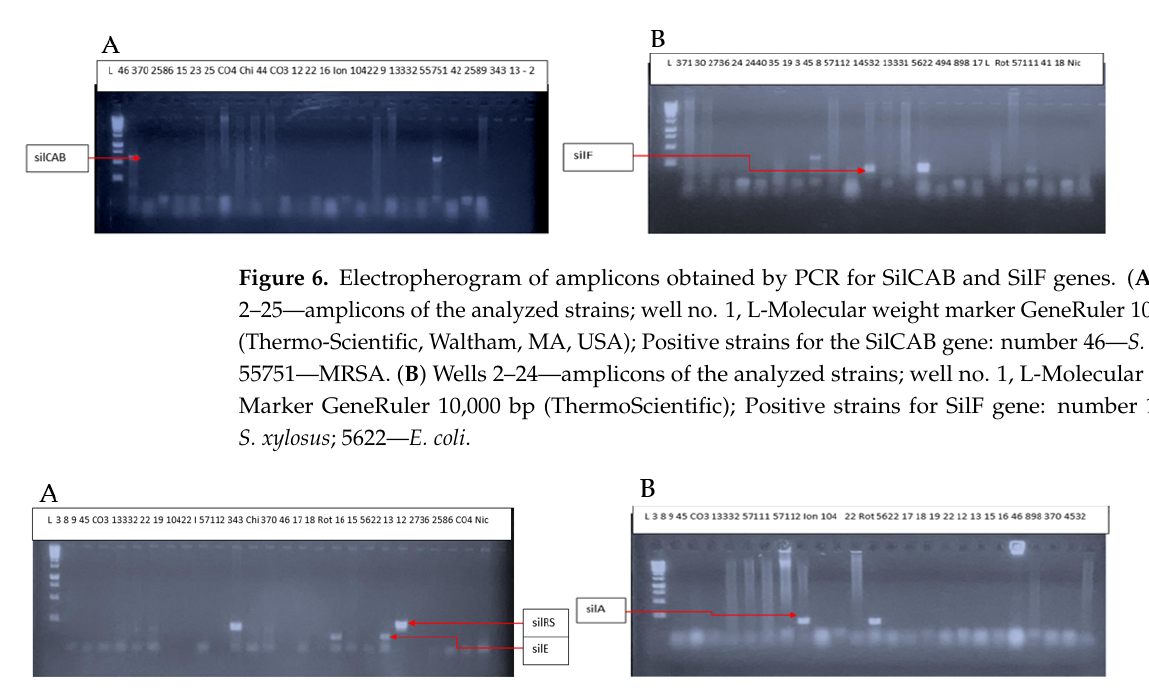
Figure 7. Electropherogram of amplicons obtained by PCR for SilE and SilRS genes. ( A ) Wells 2–28—amplicons of the analyzed strains; well no. 1, L-Molecular Weight Marker GeneRuler 10,000 bp (ThermoScientific); Positive strains for the SilRS gene: number 12— S. chromogenes ; 343—MRSA; for the SilE gene: 5622— E. coli ; ( B ) Electropherogram of amplicons obtained by PCR for SilA and SilP genes: wells 2–25—amplicons of the analyzed strains; well no. 1, L-Molecular Weight Marker GeneRuler 10,000 bp (ThermoScientific); Positive strains for the SilA gene: number 112.